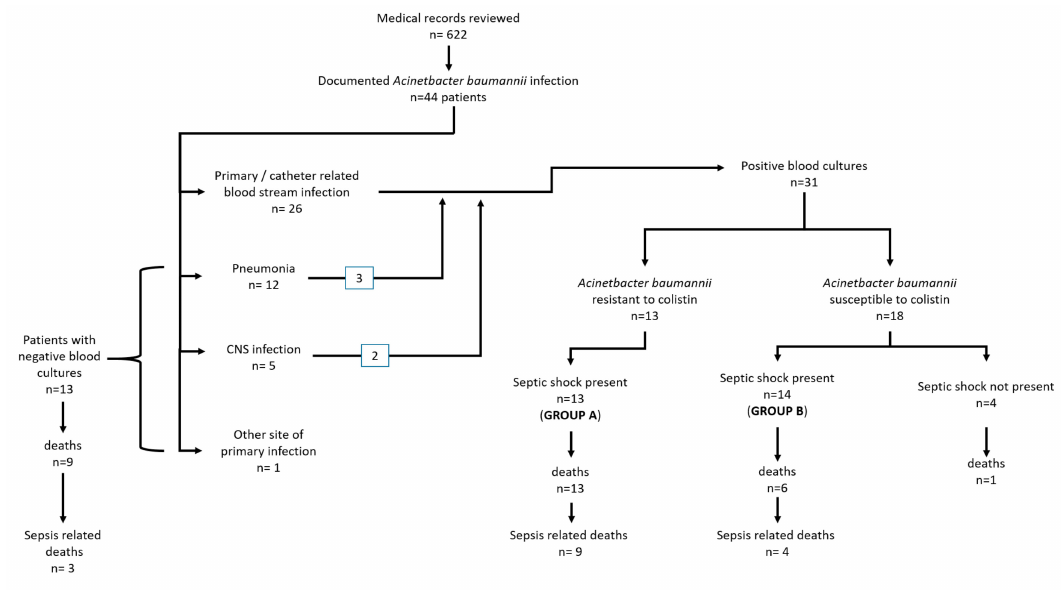
Figure 1. Study population flowchart. CNS: Central Nervous